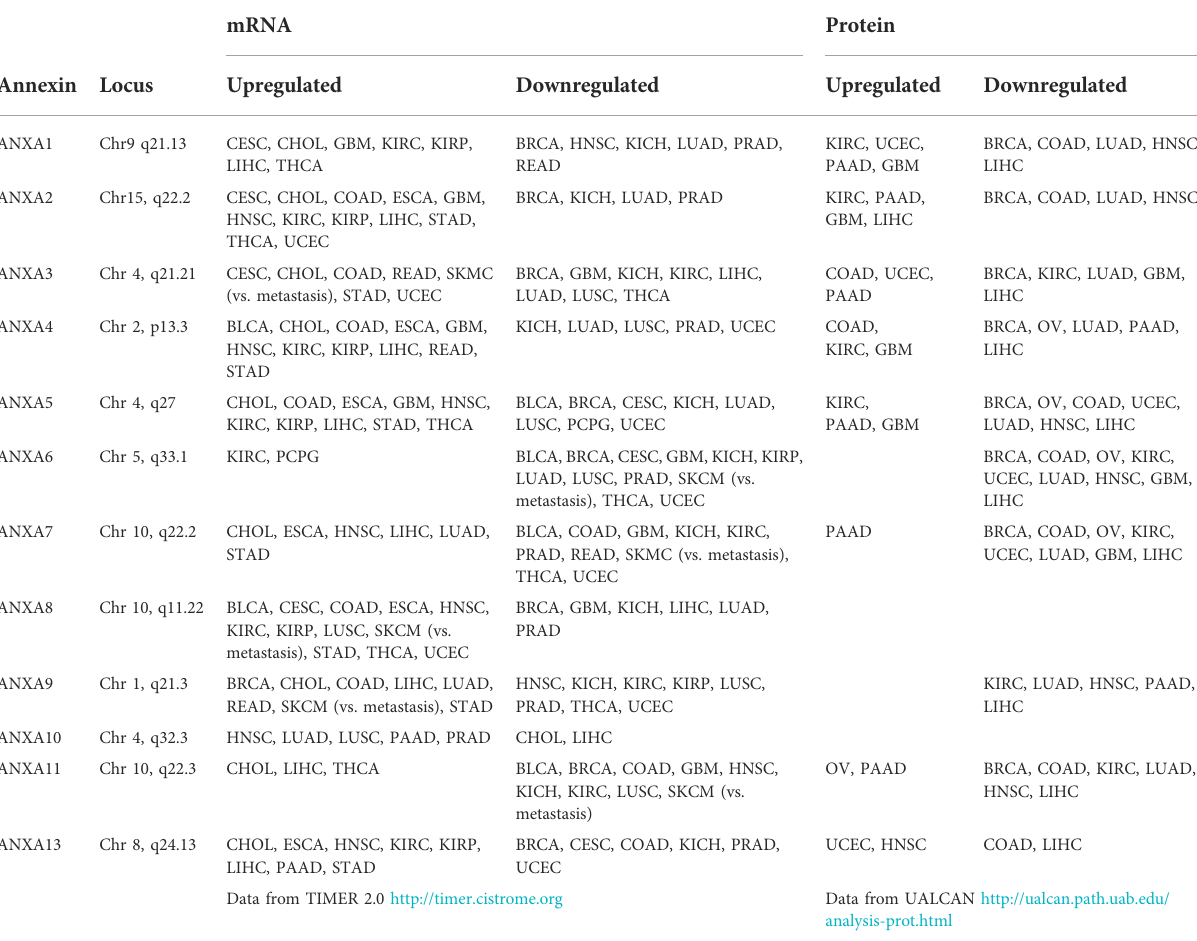
TABLE 1 Overview of annexin expression dysregulation in human cancers vs. normal samples (unless stated otherwise). Transcriptomic and protein data was obtained from TCGA and CPTAC, respectively. TIMER 2.0 (http://timer.cistrome.org/) was used to asset differences in expression level whereas UALCAN webtool (http://ualcan.path.uab.edu/) was used for protein levels. Overview of annexin expression dysregulation in human cancers VS. normal